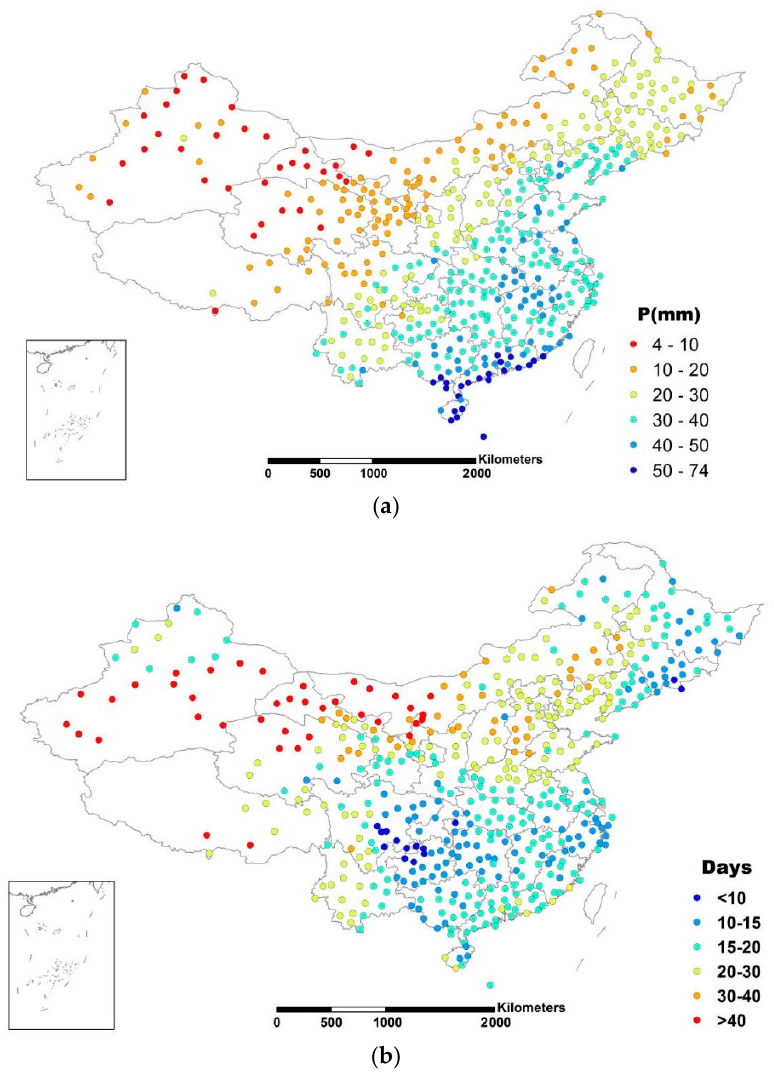
Figure 4. Threshold spatial distributions of ( a ) precipitation extreme and ( b ) drought extreme.